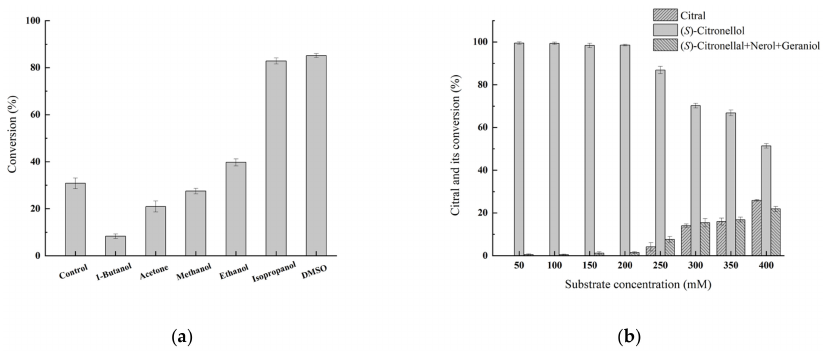
Figure 5. Effect of co-solvent ( a ) and substrate concentration ( b ) on enzymatic double reduction of ( E / Z )-citral to ( S )-citronellol. ( a ), the reaction mixture (10 mL) contained 200 mM ( E / Z )-citral, 600 mM glucose, 1 g wet cells, 0.4 mM NADP + , 20% ( v/v ) co-solvent and 50 mM PIPES buffer (pH 6.5). ( b ), the reaction mixture (10 mL) contained 50–400 mM ( E / Z )-citral, 150–1200 mM glucose (3 molar equivalents of citral), 1 g wet cells, 0.4 mM NADP + , 20% ( v/v ) isopropanol and 50 mM PIPES buffer (pH 7.0). The reactions were conducted at 30 ◦ C and 400 rpm for 12 h. Standard deviations are indicated in the diagram ( n =